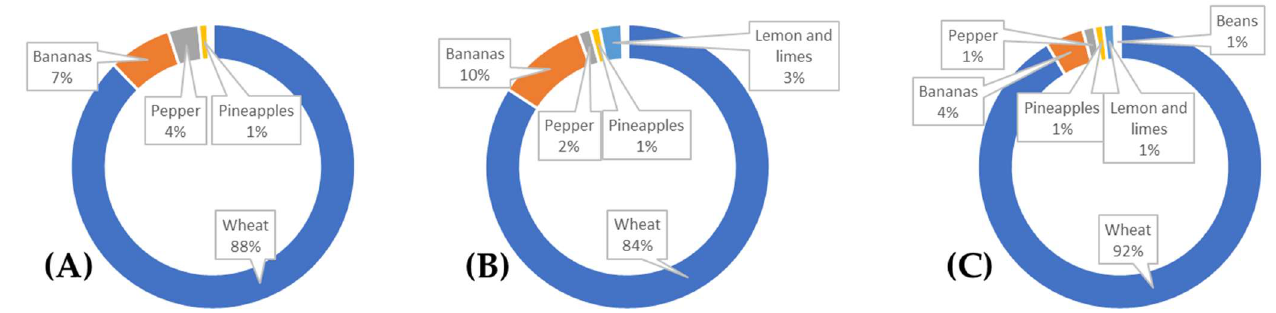
Figure 13. Exports of Sri Lanka during 2010–2020: ( A ) total quantities, ( B ) virtual water, ( C ) virtual land for top nine crops.